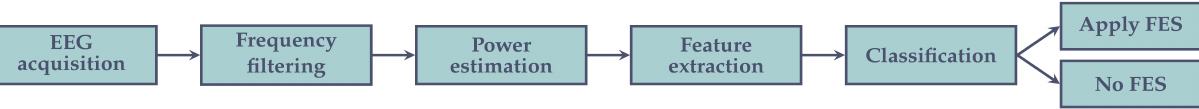
Figure 1. Typical BCI acquisition chain. After acquiring the EEG signal, the frequency components outside the band of interest are filtered out. Then, the power of the signal is estimated, followed by the extraction of its features to be used to classify if FES needs to be applied or not.